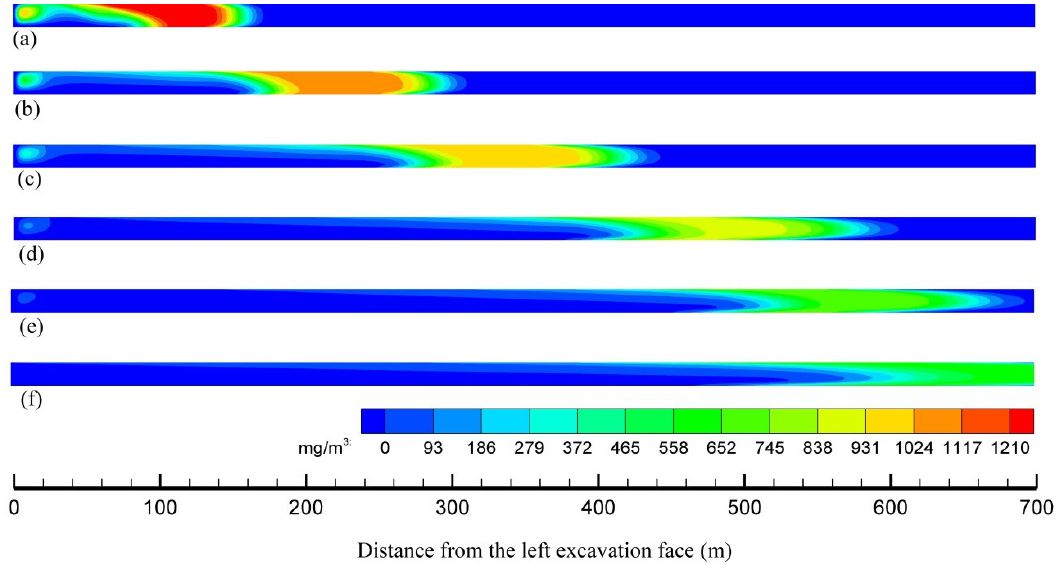
Figure 10. CO mass concentration distribution in the central axial plane. ( a ) Ventilation for 5 min; ( b ) Ventilation for 10 min; ( c ) Ventilation for 15 min; ( d ) Ventilation for 20 min; ( e ) Ventilation for 25 min; ( f ) Ventilation for 30 min.